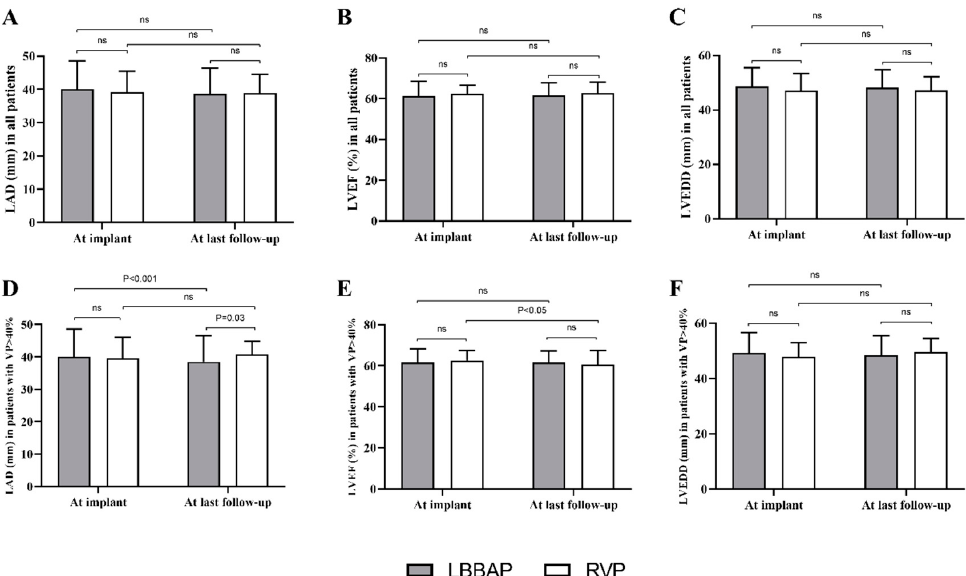
Figure 2. Echocardiographic measurements between LBBAP and RVP at baseline and during follow-up. ( A – C ) There were no significant difference in cardiac structure and function between LBBAP and RVP group during follow-up (all p > 0.05); ( D – F ) Among patients with VP% > 40%, decreased LAD (40.1 ± 8.5 mm at implant vs 38.5 ± 8.0 mm at last follow-up, p < 0.001) and LVEF (62.7 ± 4.8% at implant vs 60.5 ± 6.9% at last follow-up, p < 0.001) were observed in LBBAP group and RVP group, respectively; ns = non-significant; LBBAP = left bundle branch area pacing; RVP = right ventricular pacing; LAD = left atrial diameter; LVEF = left ventricular ejection fraction.